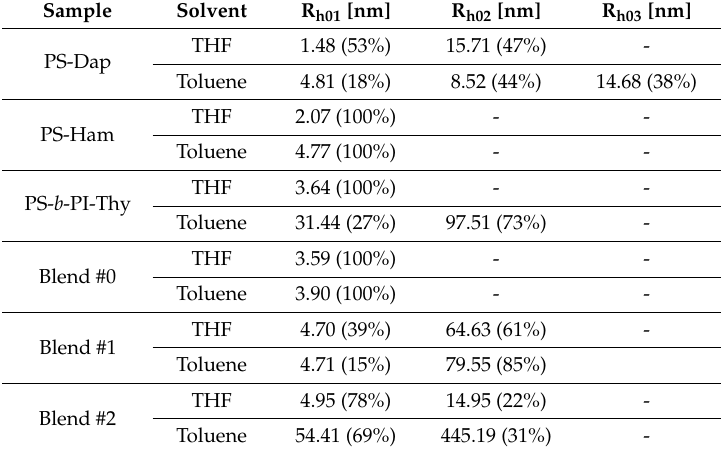
Table 4. DLS results for various samples in THF and toluene (values in parentheses indicate the percentage of each population from CONTIN